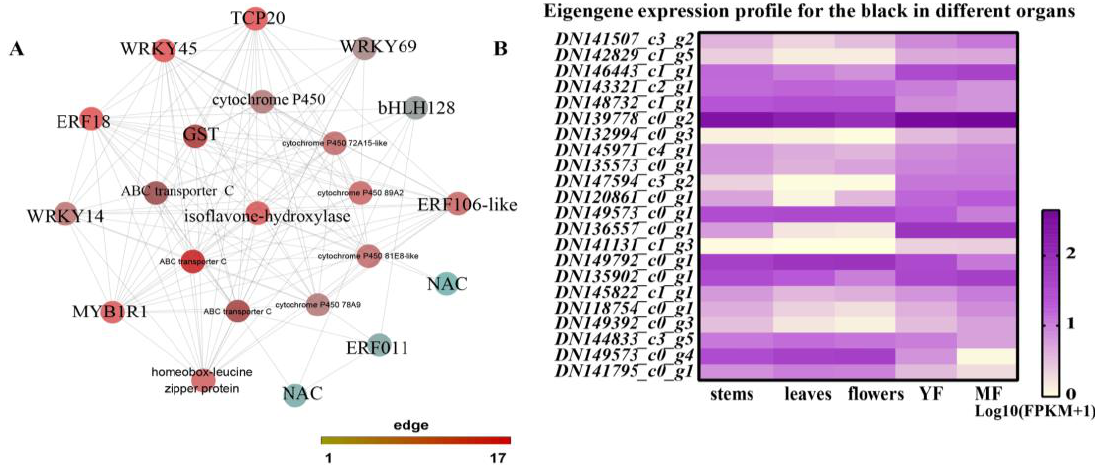
Figure 6. Cytoscape representation of co-expressed genes with edge weight ≥ 0.80 in module “black”. ( A ) The edge number of the genes ranges from 1 to 17 (color-coded by the scale on the right from yellow through red). ( B ) Eigengene expression profile for the black in five organs. YF, young fruits; MF, mature fruits.